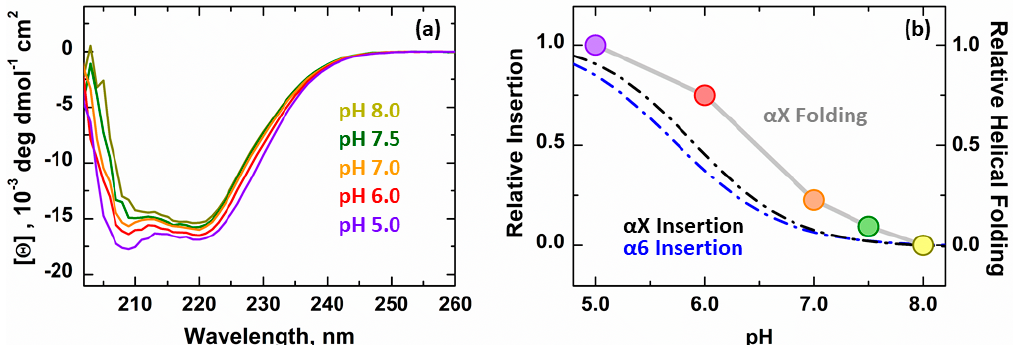
Figure 4. CD measurements of secondary structure changes of Bcl-xL in cardiolipin-containing bilayers. ( a ) The secondary structure of Bcl-xL was measured by circular dichroism in the presence of anionic 1TOCL:2POPC LUV. Under all conditions, the CD spectrum of Bcl-xL presented a double minimum at ~ 209 and 222 nm, characteristic of α -helical conformations. This was consistent with its high X-ray and NMR structures, showing an all α -helical conformation [14]. Inducing the membrane insertion of Bcl-xL through protonation led to a progressive increase in ellipticity at 209 and 222 nm, indicative of a larger α -helical content. ( b ) The relative change in ellipticity at 222 nm, an indicator of α -helical content, at each condition was compared to the protonation-dependent insertion of the α 6 helix in blue (Figure 1d, black) and partitioning of the α 1-2 loop in black (Figure 3b, red). The helical form of the α 1-2 loop in the bilayer is hereby referred to as helix α X. The di ff erence in pH dependence between the insertion and folding data suggested that the bilayer interactions of Bcl-xL did not follow a simple two-state pathway (see also Figure 6).